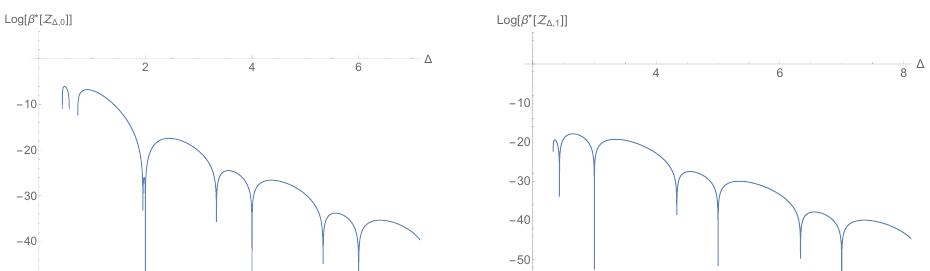
Figure 8. The extremal functional (cid:12) (cid:3) acting on spin-0 (left) and spin-1 (right) primaries at c = 6 and (cid:1) t = 4 3